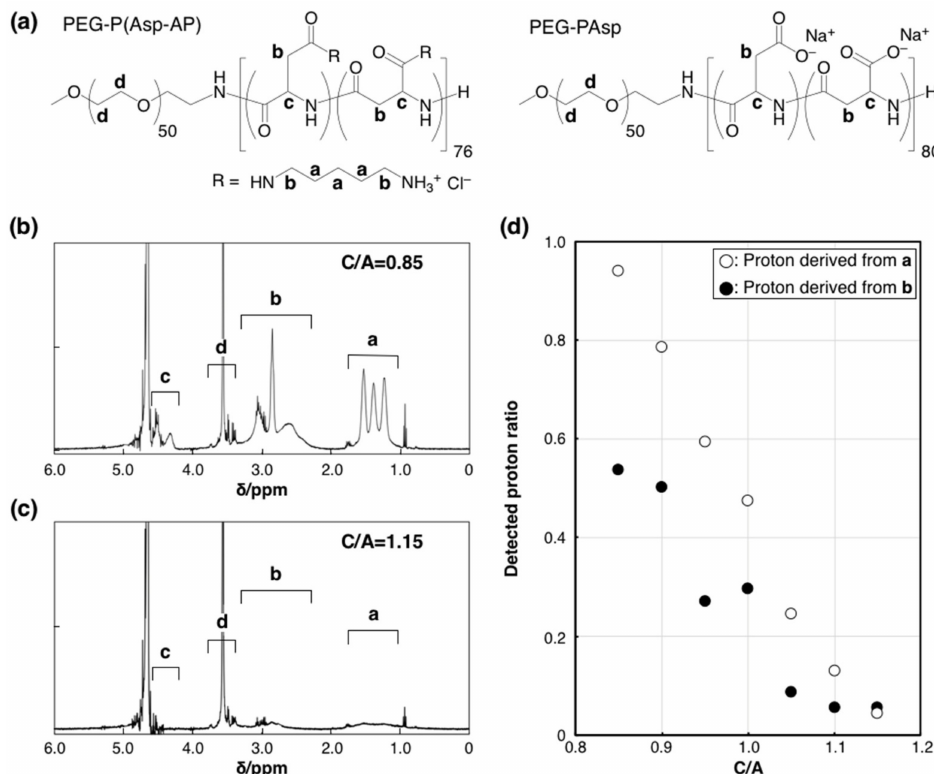
Figure 2. 1 H-NMR analysis of the PIC/m core. ( a ) Chemical structures of PEG-P(Asp-AP) and PEG-PAsp. 1 H-NMR spectra of PIC/m prepared with a mixing ratio of C/A ( b ) at 0.85 and ( c ) 1.15 (10 mM deuterium phosphate buffer (pD = 7.0), 400 MHz, 37 ◦ C). a, b, c and d denote each proton of chemical structures in ( a ). ( d ) Detected proton ratio between PIC/m and polymers (open and closed circles denote proton derived from “a” and “b” of ( a